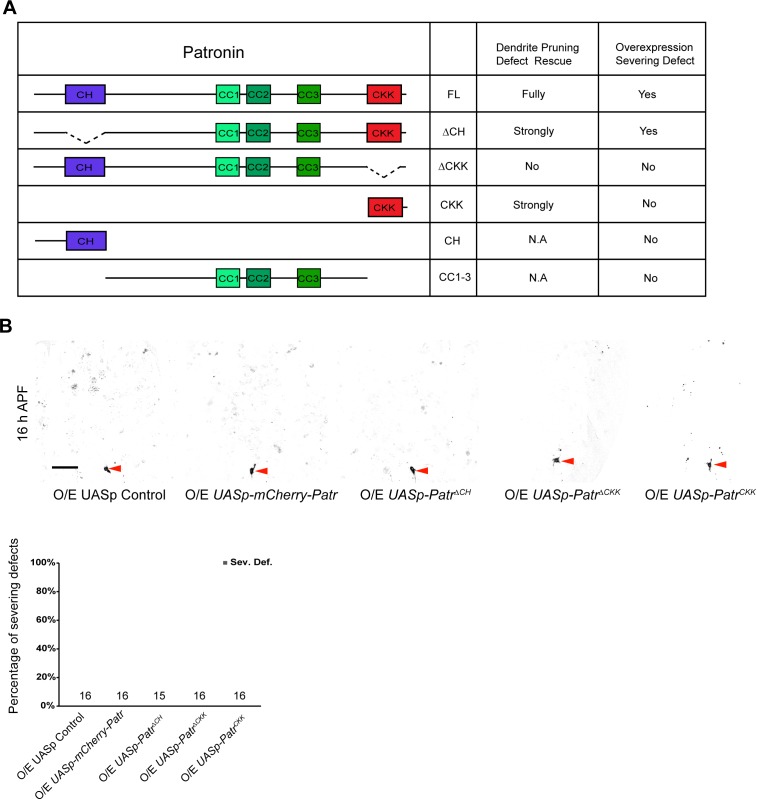
Structure-function analysis of the Patronin protein.(A) A schematic representation of full-length and truncated Patronin proteins and a summary of structure-function analysis of Patronin. Patronin contains multiple domains: a calponin homology (CH) domain at the N-terminus, three coiled-coil (CC) repeats at the central region, and a signature CKK domain at the C-terminus. N.A., not available. (B) Confocal images of ddaC neurons expressing mCD8-GFP driven by two copies of ppk-Gal4 at 16 hr APF. Similar to the control neurons, UASp-mCherry-Patr, UASp-PatroninΔCH, UASp-PatroninΔCKK or UASp-PatroninCKK-expressing ddaC neurons pruned away their larval dendrites by 16 hr APF. Red arrowheads point to the ddaC somas. Quantification of the severing defects in the control and mutant ddaC neurons at 16 hr APF. The number of samples (n) in each group is shown on the bars. Scale bar in (B) represents 50 µm.10.7554/eLife.39964.012Figure 3—figure supplement 1—source data 1.Extended statistical data as Microsoft Excel spreadsheet.